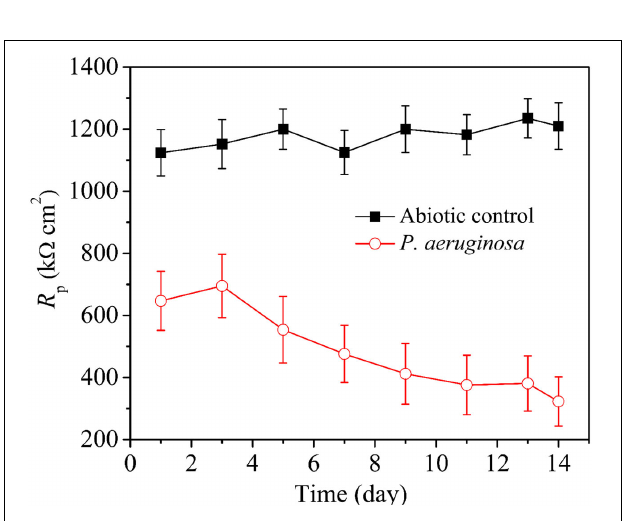
FIGURE 7 | Variations of LPR polarization resistance under different conditions vs. time during the 14-day incubation with and without P. aeruginosa . Scatter bands are standard deviations of 3 independent